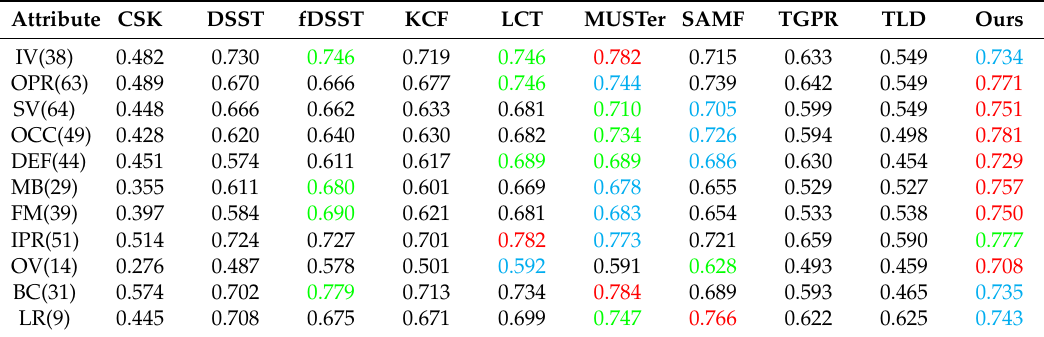
Table 2. Attribute-based analysis of OTB-2015 (mean DP score). The first, second and third highest results are colored red, green and blue, respectively.